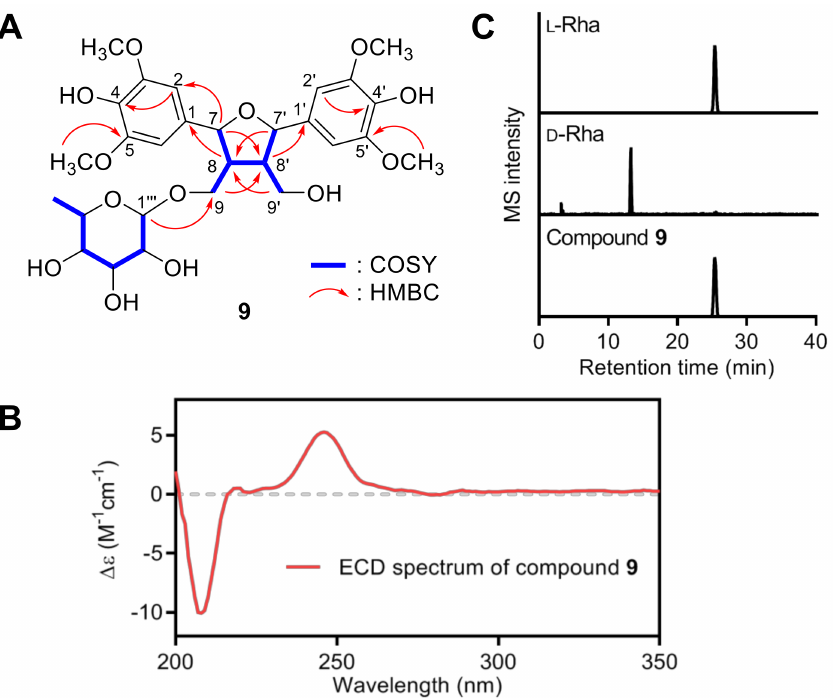
Figure 3. Structure elucidation of 9 . ( A ) Key COSY and HMBC correlations of 9 . ( B ) Extracted ion chromatograms (EICs, m / z 431.1311) of chiral derivatized L - and D -rhamnopyranose purchased or obtained by hydrolysis of 9 . ( C ) ECD spectrum of 9 . The positive Cotton effect at 246 nm indicated the 7 R ,7 (cid:48) R ,8 S ,8 (cid:48) S